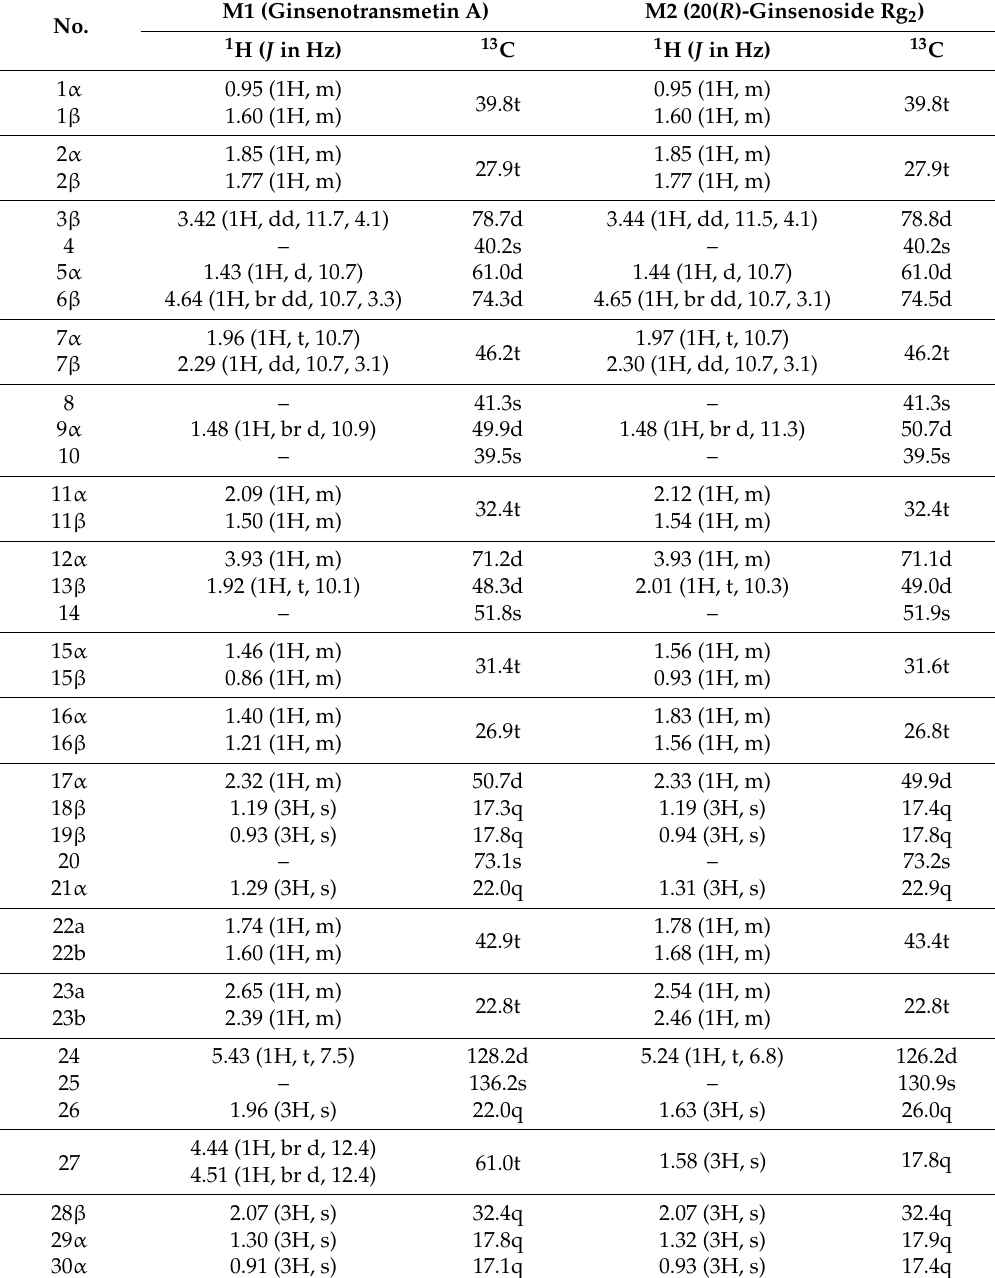
Table 1. 1 H- and 13 C-NMR data in pyridine- d 5 ( δ ppm ) of aglycone parts of M1 and M2 a